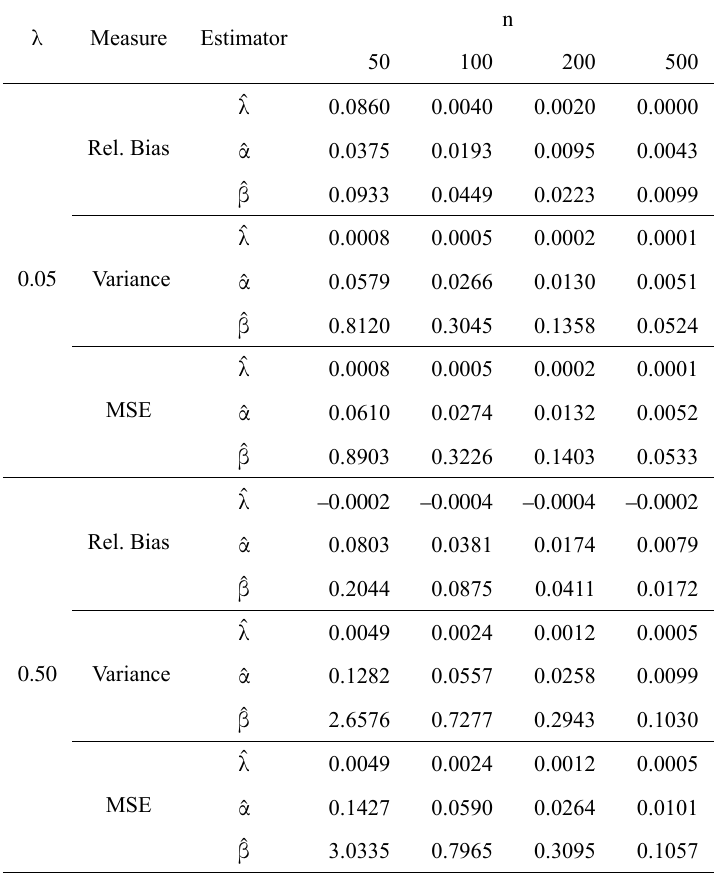
Relative biases, variances and MSEs of the maximum likelihood estimators of the parameters that index the IK 1 distribution; α = 1.5, β = 3.0 α = 1.5, β = 3.0 α = 1.5, β = 3.0